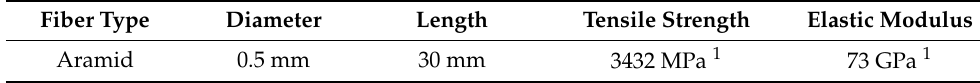
Table 2. Matrix mixture proportion.